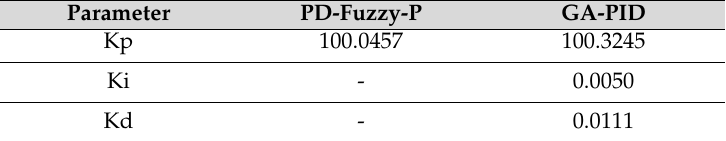
Figure 8. The result of the tracked trajectories: ( a ) is the squared path, ( b ) is the circular path, and ( c ) is the rose path. Table 4. Parameters of the PD-Fuzzy-P and GA-PID controllers.